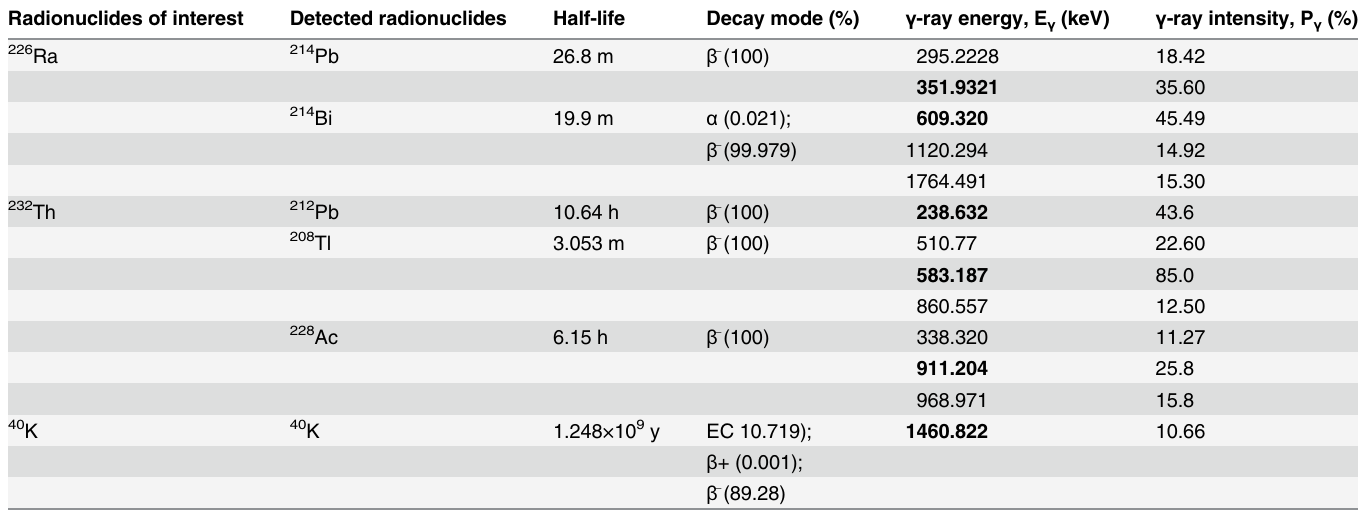
Table 2. Decay data of the detected radionuclides of interest (Source: http://www.nndc.bnl.gov/nudat2/). Radionuclides of